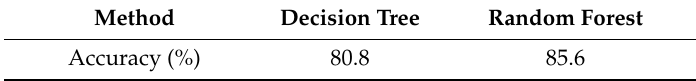
Table 2. Charging prediction accuracy with di ff erent prediction